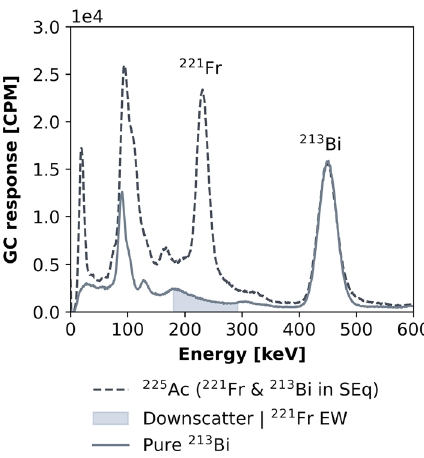
Fig. 1 GC photon energy spectrum measured for 225 Ac, in SEq with both 221 Fr and 213 Bi, and for pure 213